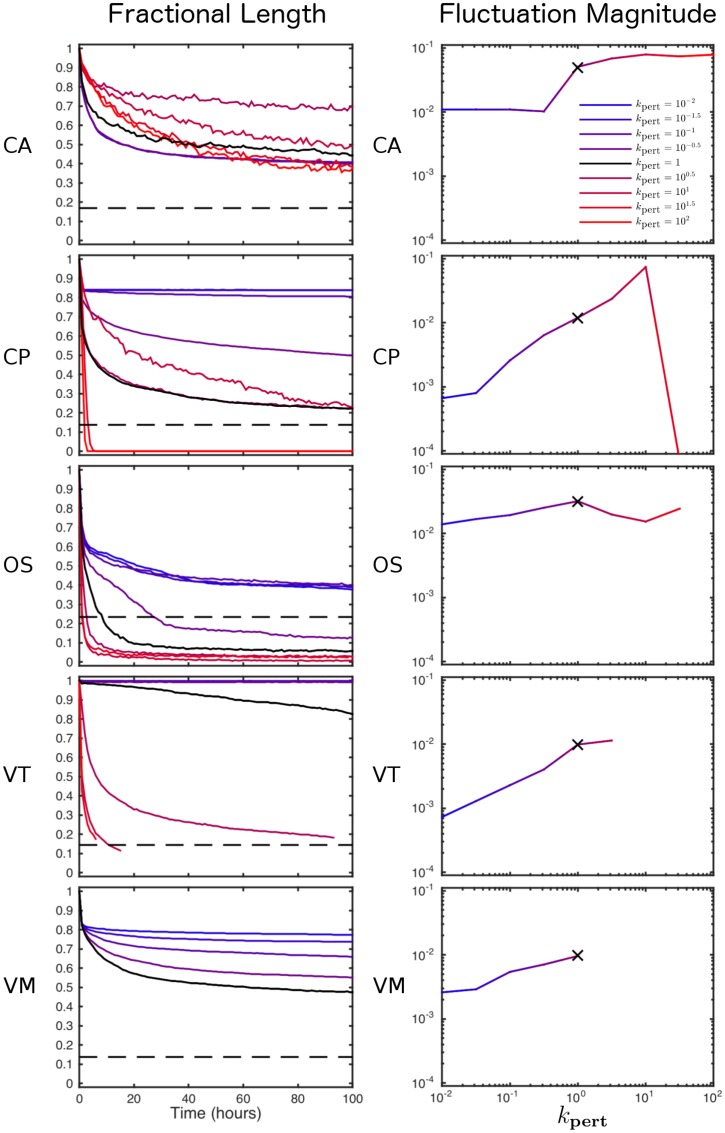
Comparison of cell sorting dynamics across differential adhesion simulations.Left, as a measure of sorting, the fractional length is computed as a function of time for each model. Results are shown for varying multiples of the baseline level of noise, T or ξ (whose value is defined for each model in Table 2), by multiplying by kpert. Each line is the mean value of 10 simulations. Right, the magnitude in the fluctuation of the fractional length curves (calculated as the mean squared error between the original curves and smoothed versions of the same curves, using a 10 hour smoothing range). The simulations from Fig 2 (with kpert = 1) are denoted, on the left and right, by black lines and black crosses, respectively. Parameter values are given in Tables 1 and 2.